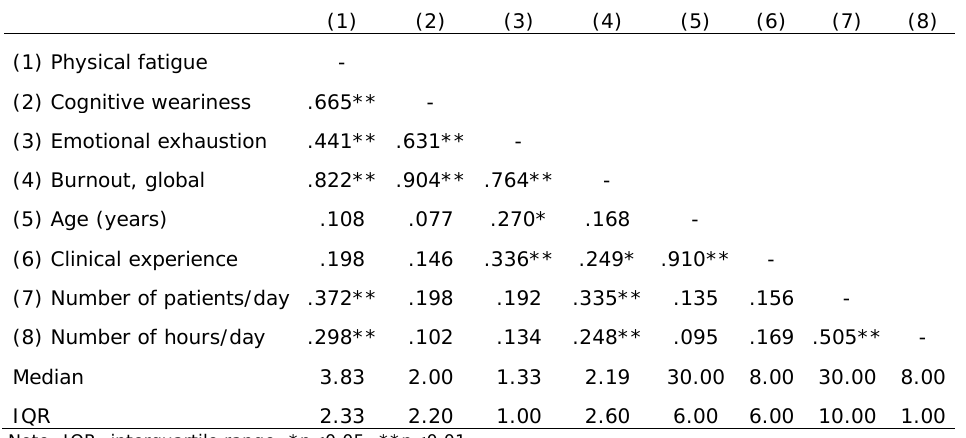
Table 1. Correlation matrix and descriptive statistics for burnout, age and work-related